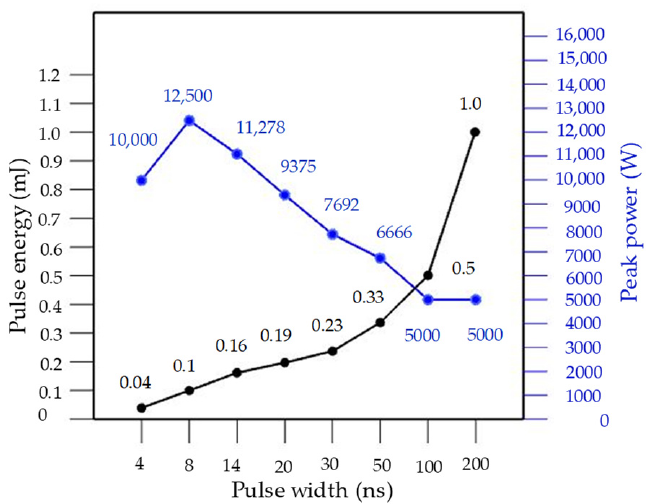
Figure 12. Correlation between variation in pulse width, pulse energy, and peak power. The pulse energy increases with an increase in pulse width. The maximum pulse width of 200 ns corresponds to the lowest peak power 5000 W.